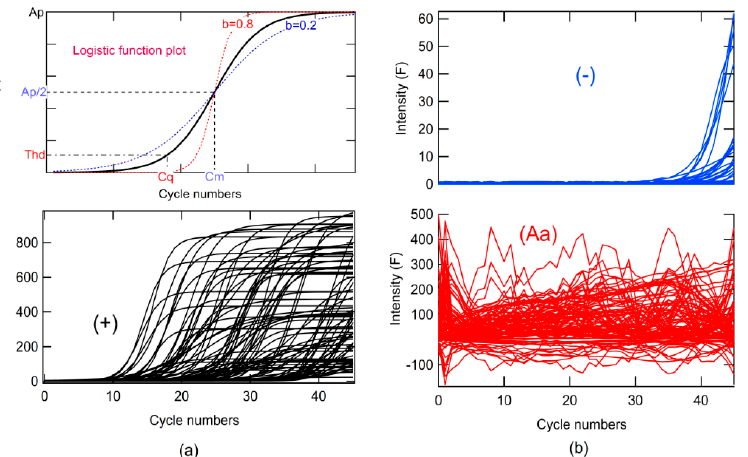
Figure 3. ( a ) Logistic function plot for different growth rate parameters used in the simulations and simulated real-time RT-PCR curves for a class; ( b ) simulated real-time RT-PCR curves for classes no amplification (–) and abnormal amplification ( Aa ).